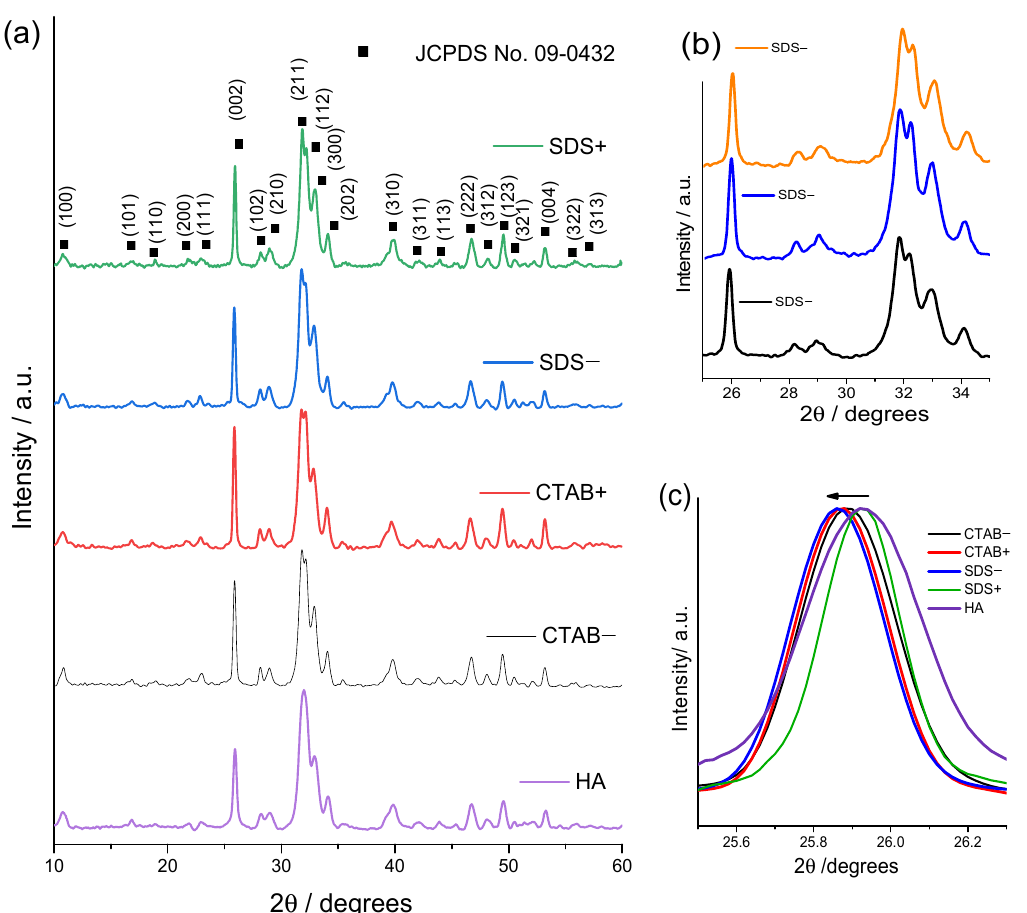
Figure 1. ( a ) XRD patterns of HA, CTAB − , CTAB+, SDS − , and SDS+ samples; ( b ) repeated measurements of the SDS − sample within a range of 2 θ = 25–35 ◦ ; and ( c ) shift of the peak resulting from (002) plane. Table 1. Lattice parameters, FWHM of the (002) peak, crystallite size, I 002 /I 211 , and L/D ratio of the hydroxyapatite samples. Samples Lattice Parameter (nm) HA